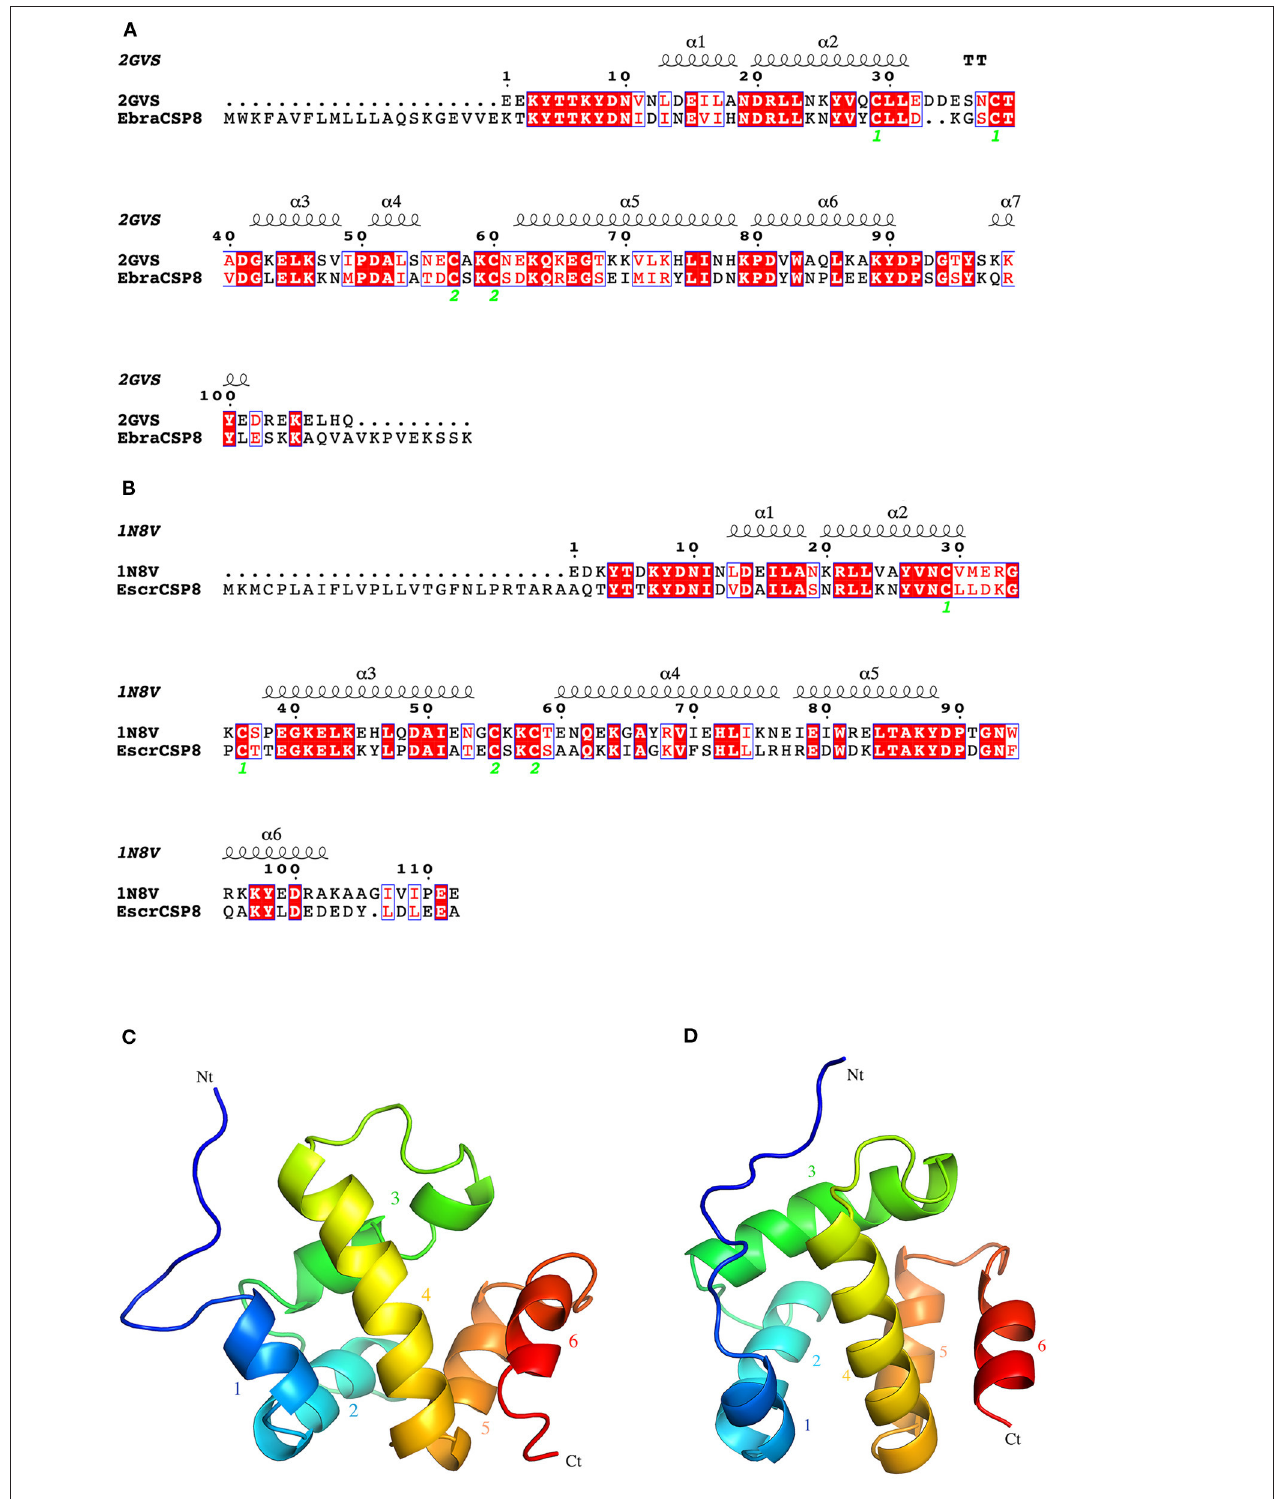
FIGURE 5 | 2D and 3D structures of EbraCSP8 and EscrCSP8a. (A) 2D structure of EbraCSP8; (B) 2D structure of EscrCSP8a; (C) 3D structure of EbraCSP8; (D) 3D structure of EscrCSP8a.